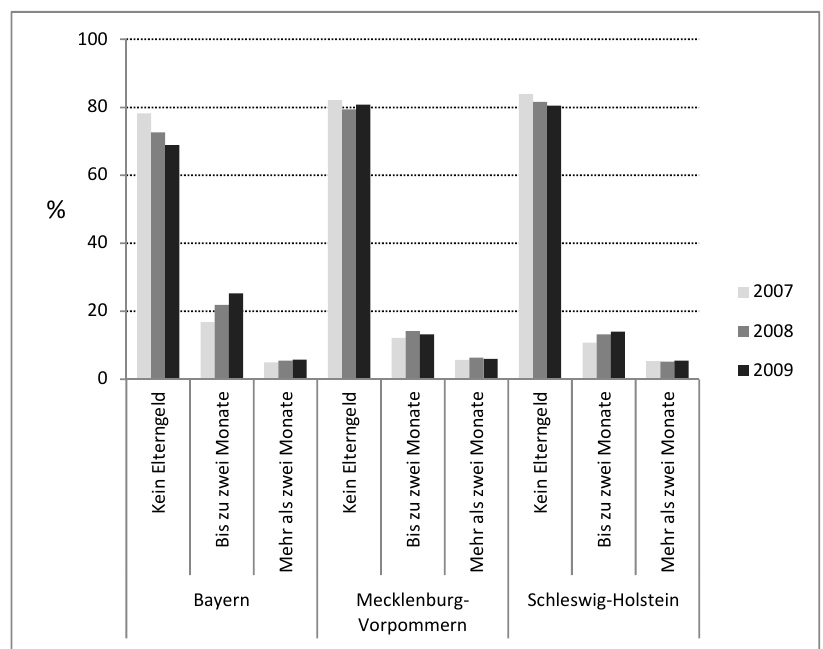
Quelle: Daten des Elterngeldbezugs in BY bereitgestellt durch das Zentrum Bayern Familie und Sozia- les, Daten des Elterngeldbezugs in MV bereitgestellt durch das Landesamt für Gesundheit und Soziales (LAGuS), Daten des Elterngeldbezugs in SH bereitgestellt durch das Landesamt für soziale Dienste, ei- gene